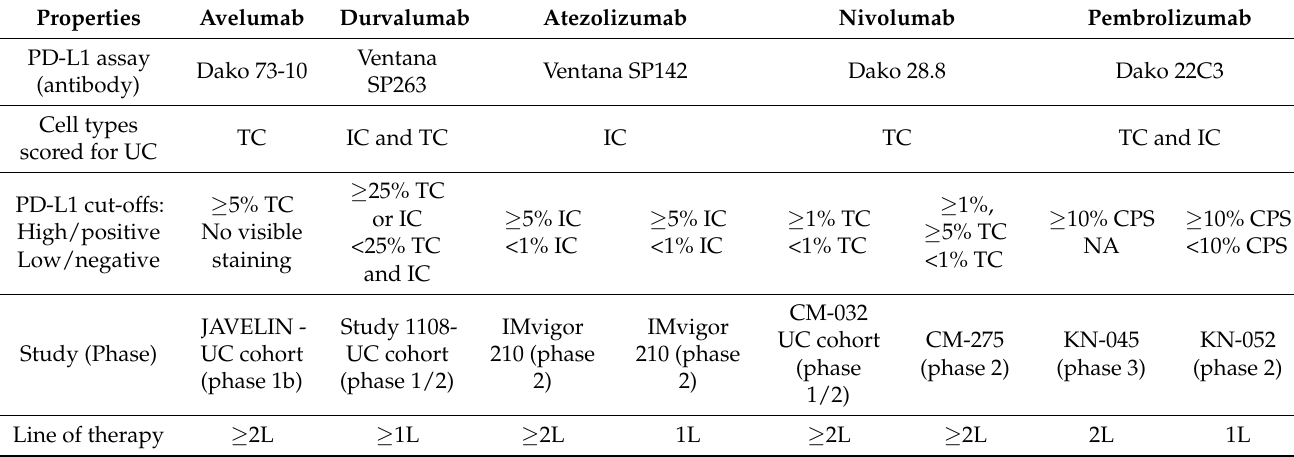
Table 3. Commonly used anti PD1-PDL1 antibodies to guide immune checkpoint blockade immunotherapy in bladder